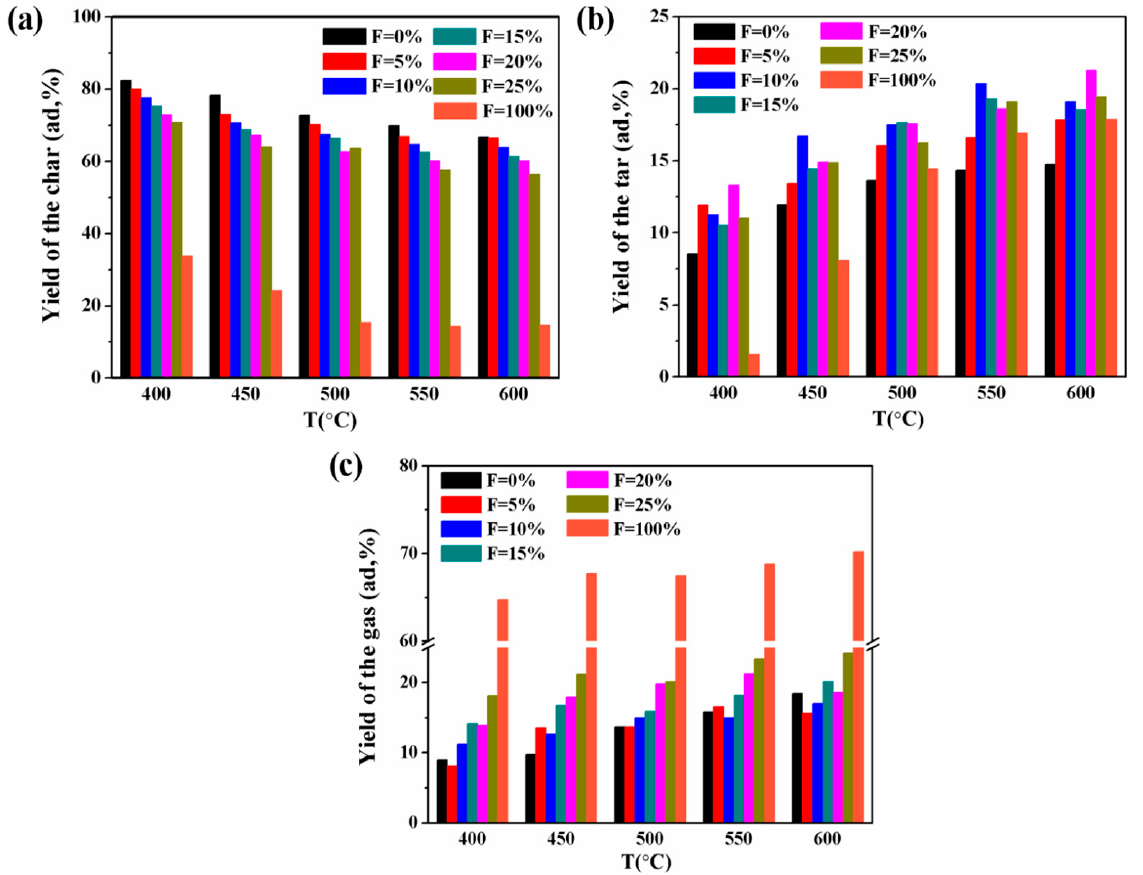
Figure 3. The yield of the pyrolysis products ( a ) char, ( b ) tar, and ( c ) gas.